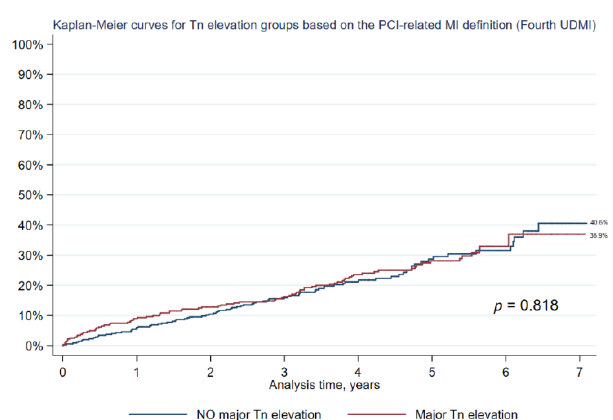
Figure 2. Kaplan-Meier analysis of all-cause mortality: major Tn elevation vs. NO major Tn eleva- tion (based on PCI-related myocardial infarction definition from the fourth universal definition of myocardial infarction).